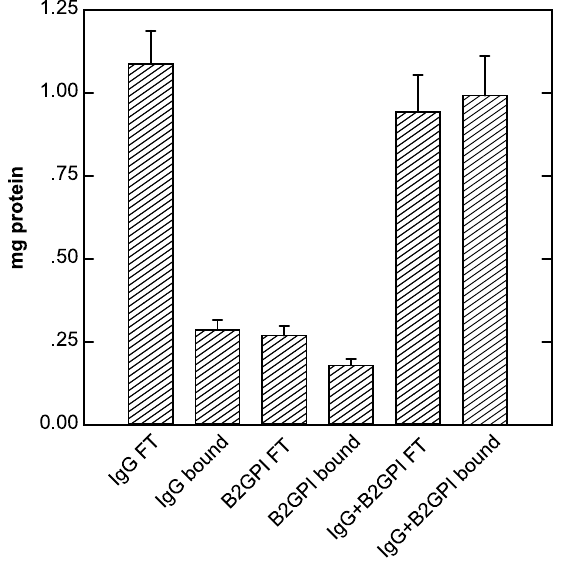
Figure 6. The influence of b 2 GPI on the binding of IgG to an ATP column. IgG (1.5mg) from a demented APS patient with high levels of aCL and b 2 GPI (0.5 mg) were applied separately or in combination to an ATP column. Fractions that flowed through the column (FT) or were bound by the column (bound) were collected and assayed for protein as described in the Methods. All protein could be eluted from the column with 500mM